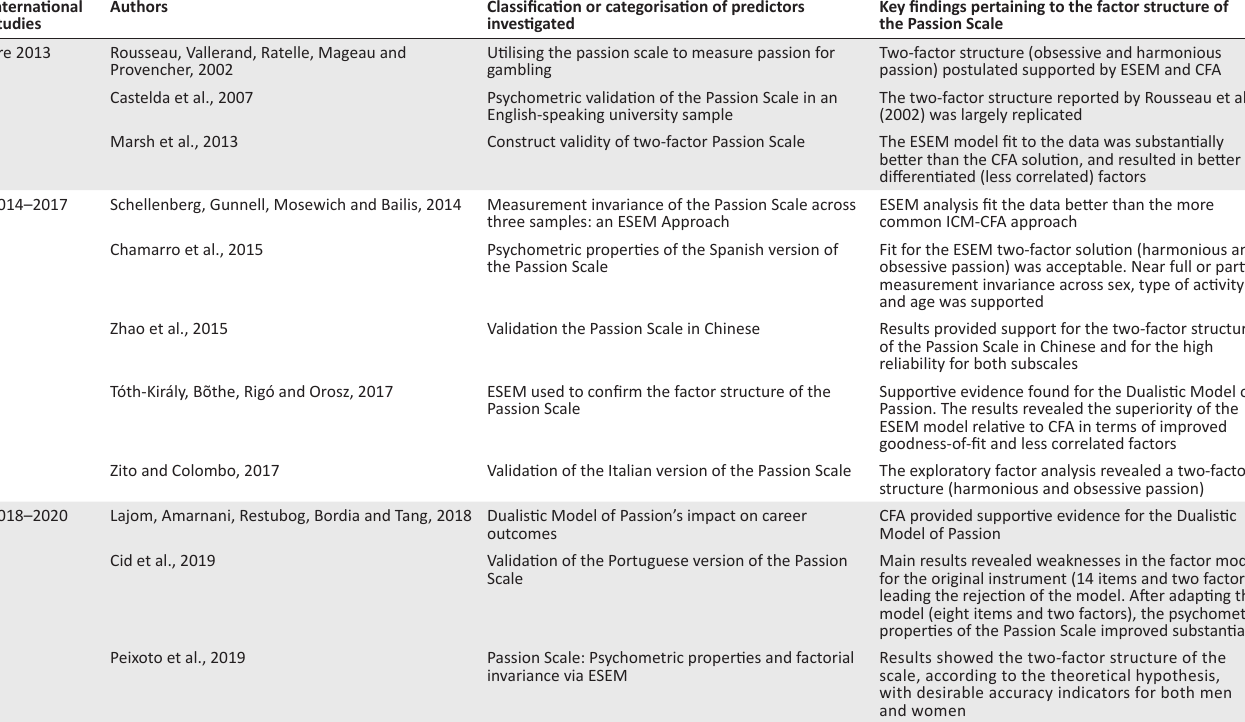
TABLE 1: Studies exploring the factor structure of the Passion